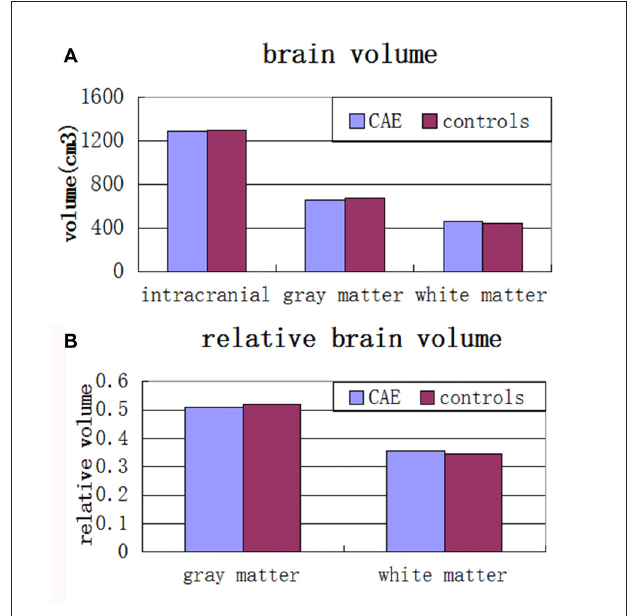
FIGURE 2 | (A) Mean total intracranial, gray and white matter volumes and (B) relative gray matter and white matter volumes in children with absence epilepsy compared to healthy controls. There were no significant group differences across any of these volumes.